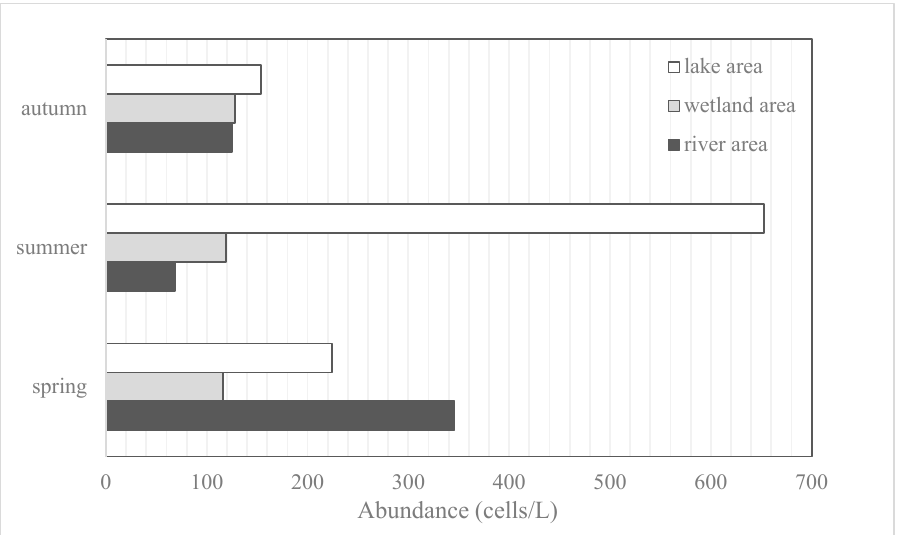
Figure 2. Distribution of average phytoplankton abundance in sampling area.